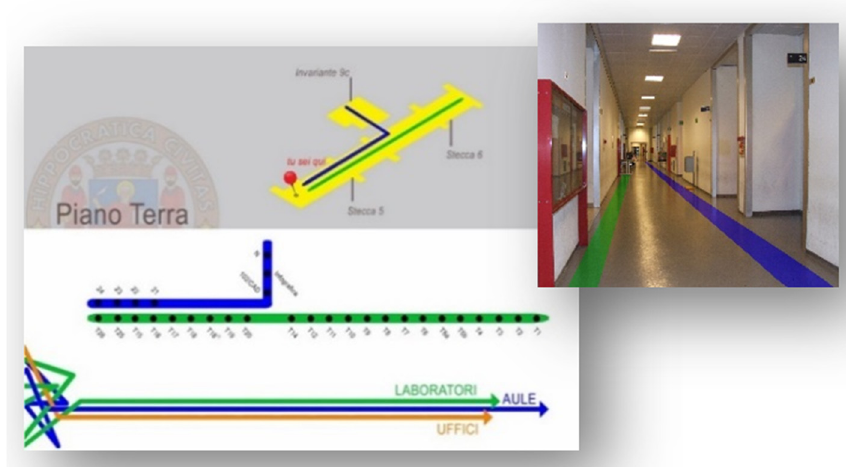
Figure 11. Map for locating rooms on plan.